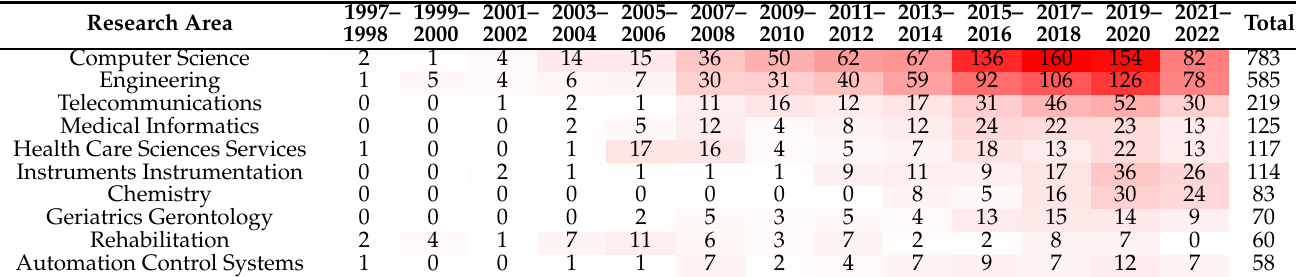
Table 3. Distribution of top 10 research areas on SHOA in two-year